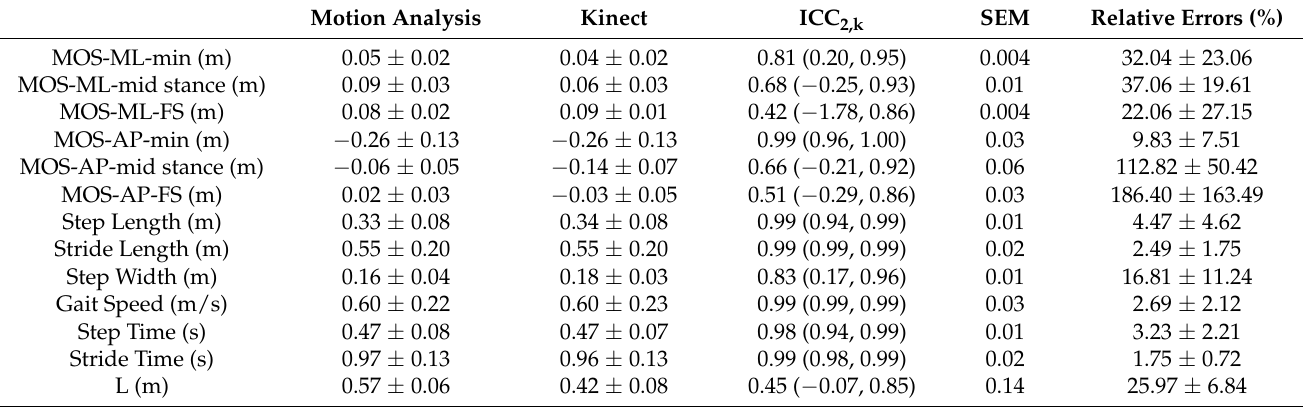
Table 3. Mean ± 1SD (n = 10) values for each MOS and spatiotemporal gait parameters collected by Motion Analysis and the Kinect on Day 1, intraclass correlation coefficient (ICC 2,k ) with 95% confidence intervals for agreement, SEM, and relative errors (in percentage) are provided. FS: foot strike; min: minimum; L: length of the pendulum. Motion Analysis Kinect ICC 2,k SEM Relative Errors (%)